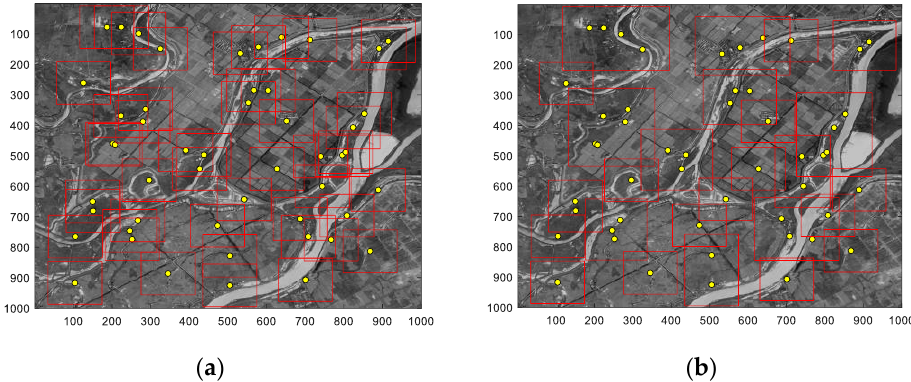
Figure 13. Template merging effect. ( a ) Before merging; ( b ) after merging. The yellow points are feature points, and their corresponding red boxes represent their respective template areas.